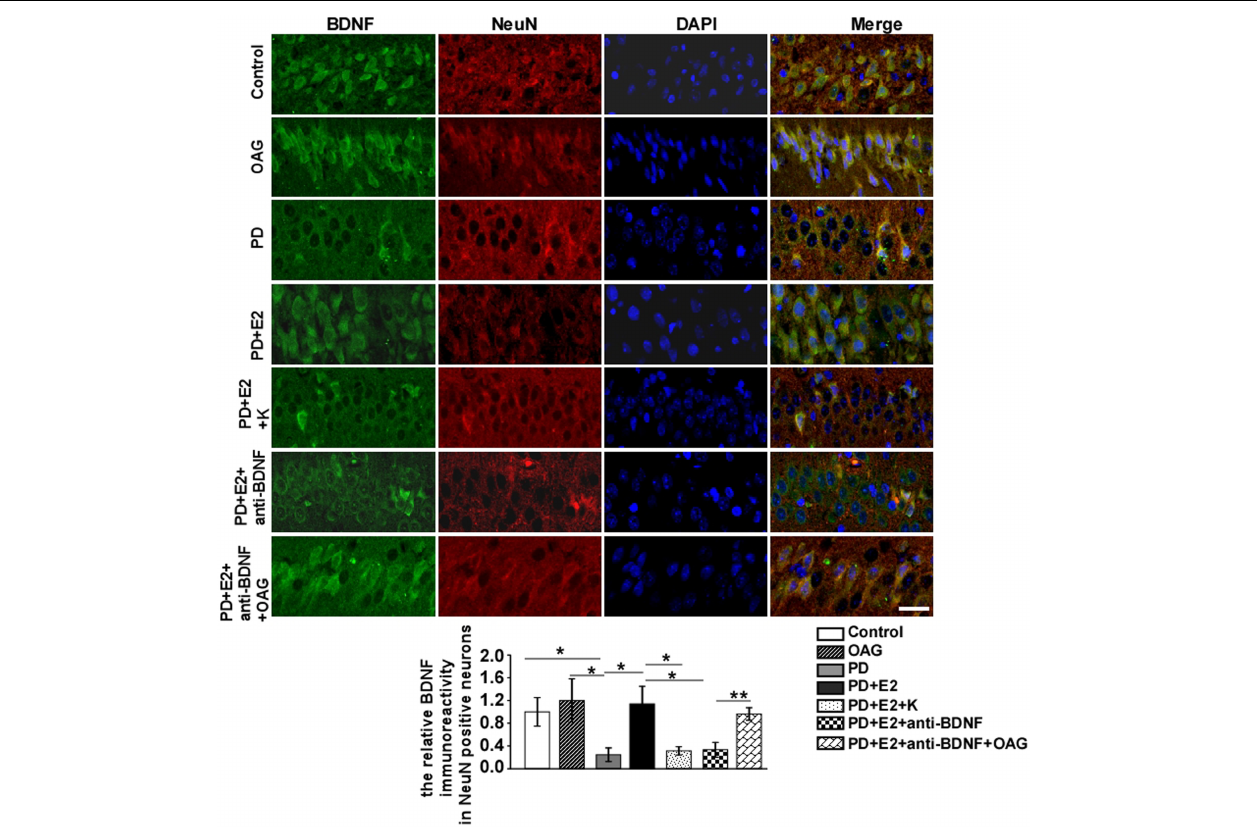
FIGURE 9 | K252a or anti-BDNF administration significantly inhibited the upregulation of BDNF expression in the hippocampal CA1 area in PD rats treated by E 2 ; further co-treatment of TRPC6 agonist blocked the above effects. Immunofluorescent micrographs showing the changes in fluorescence intensity of BDNF in NeuN-labeled neurons in the CA1 region of the hippocampus in the control group, OAG group, PD group, PD + E 2 group, PD + E 2 + K group, PD + E 2 + anti-BDNF group, and PD + E 2 + anti-BDNF + OAG group. The relative immunoreactivity of BDNF in neurons was quantified ( n = 5, each group). Data are presented as means + SEM. * p < 0.05; ** p < 0.01. Scale bar = 30 µ